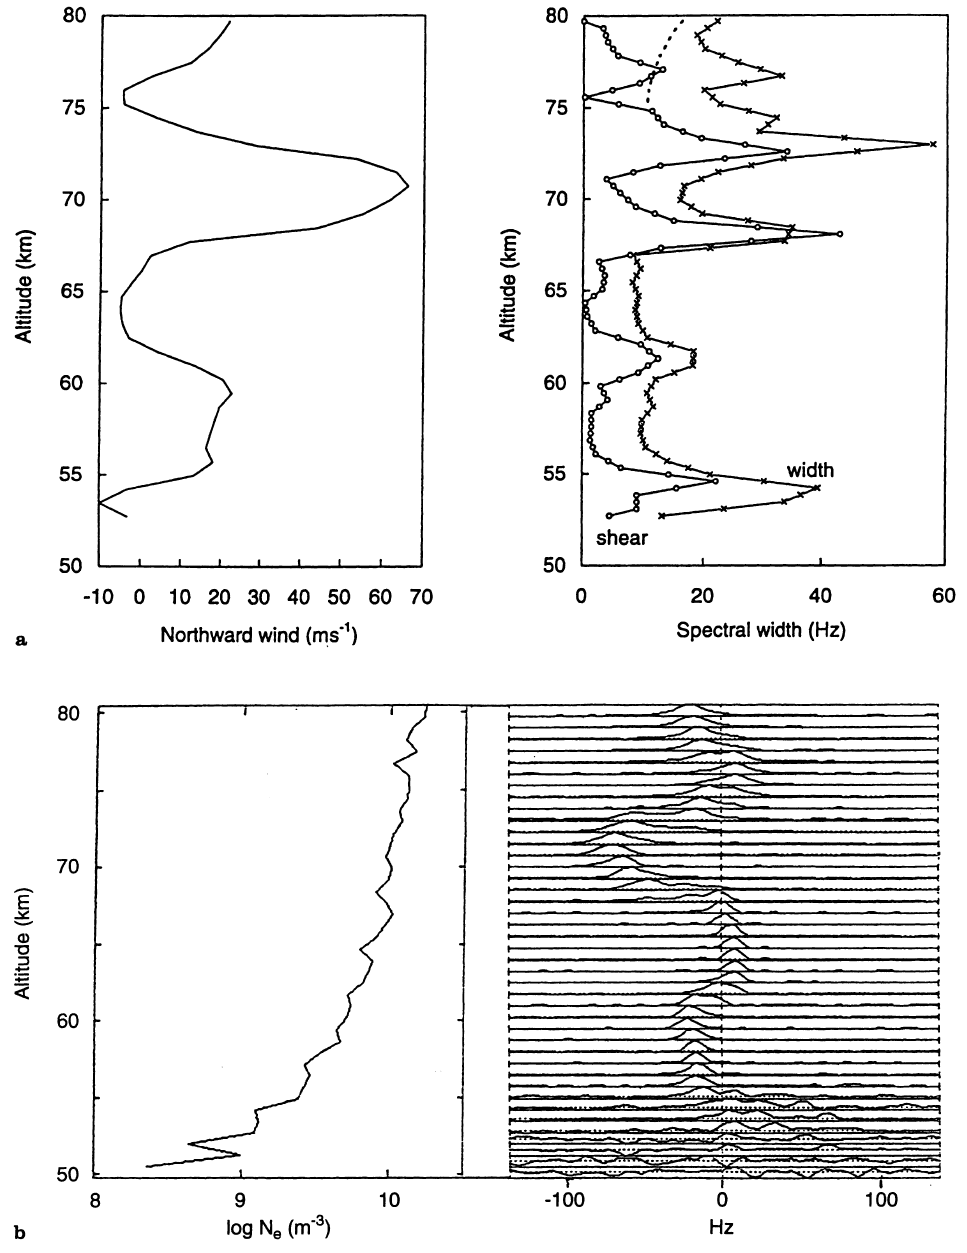
Fig. 5. a As Fig. 3, but for an antenna elevation of 45 (cid:176) at 1330 UT. b. The right panel shows measured VHF power spectra (arbitrary linear power scale) for the same time as part a. Each spectrum is